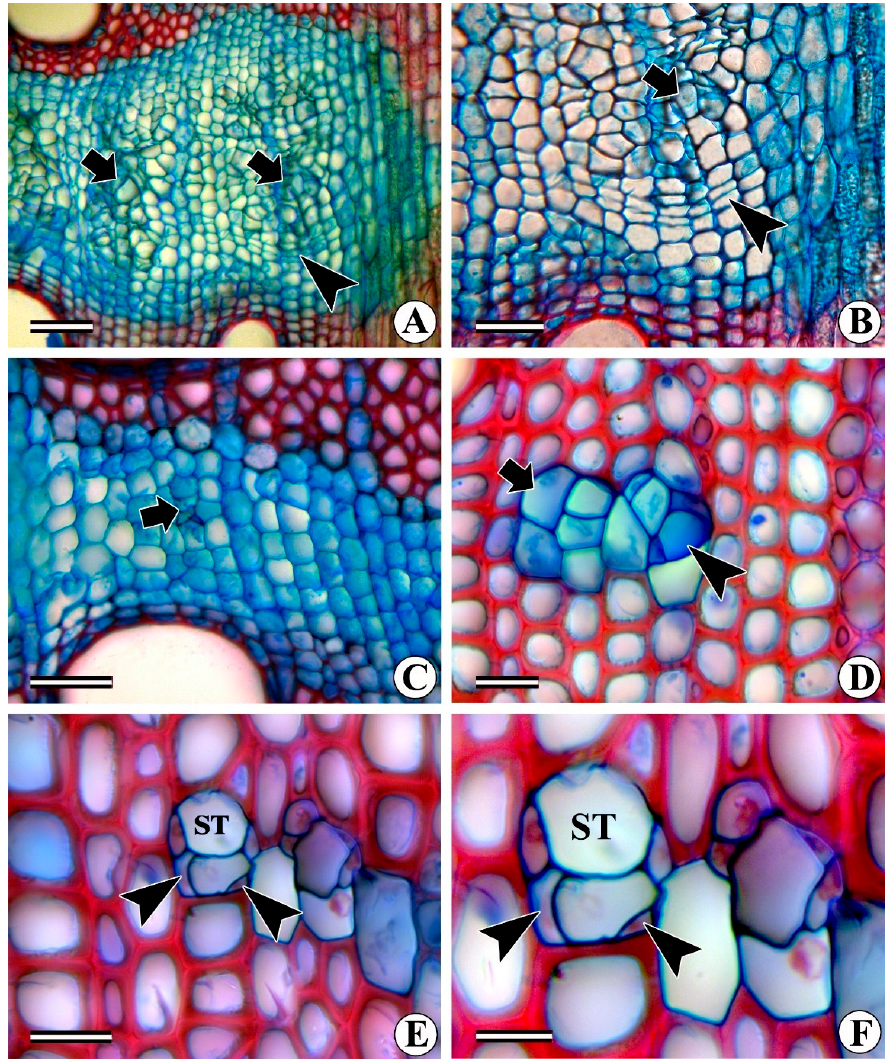
Figure 2. Transverse view of the secondary xylem showing interxylary phloem. ( A ) One of the phloem islands in Leptadenia reticulata showing the initiation of cell division in the associated parenchyma (arrowhead). Note the arrangement of cells in the radial file. Arrows indicate the sieve elements. ( B ) Enlarged view of Figure 2A showing the divisions in the associated parenchyma and the arrangement of dividing cells arranged in radial files like cambium (arrowhead). The arrow shows the sieve tube element. ( C ) One of the parenchyma islands in L. reticulata showing differentiating sieve elements (arrow) showing delayed development of phloem elements. ( D ) Secondary xylem of Barleria prionitis showing an interxylary phloem island composed of a few sieve elements (arrowhead) and associated parenchyma cells (arrow) ( E,F ) Barleria sp. (F: enlarged view of 2E) showing sieve elements (ST) with two companion cells (arrowheads). Note the companion cells with each sieve tube element. Abbreviation : ST = sieve tube element. Scale bars: A = 200 µm; B, C = 100 µm; D, E = 50 µm; F = 20 µm.